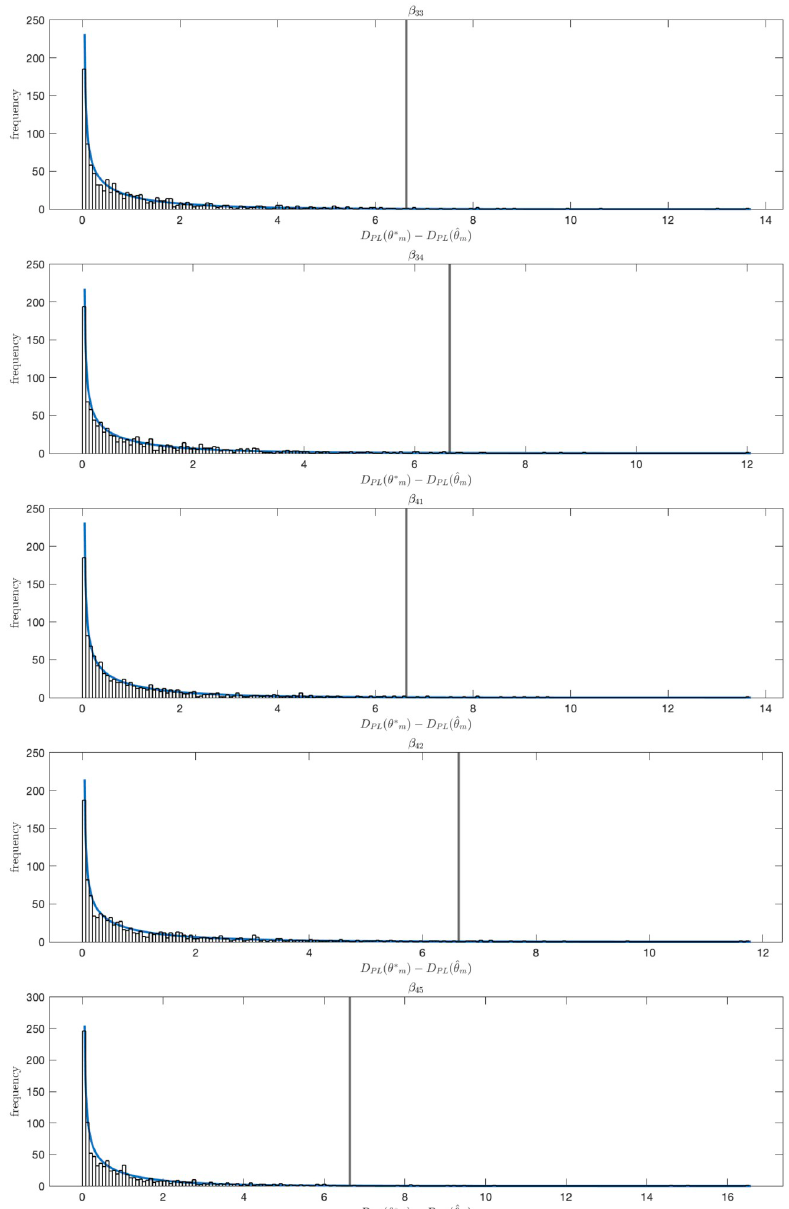
Fig 10. Validation of the coverage of the confidence intervals. The χ 2 distribution with one degree of freedom (blue) and, for a 1000 independent datasets, and for the remaining five edge parameters θ m 2 θ of the 10-edge 5 cytokine test model, a histogram of the values of D ð y � Þ (cid:0) D ð ^ y Þ , with D ð y Þ ¼ min (cid:0) 2 log ð L ð θ ÞÞ , PL PL m PL m m ~ θ m ~ θ ¼ f y ; ... ; y ; y ; ... ; y g . Here, y � ¼ 0 : 5 is the true value of θ m and ^ y its estimated value by log-likelihood 1 m m (cid:0) 1 m þ 1 N m minimization. In 99% of all cases, the value of D ð y � Þ (cid:0) D ð ^ y Þ is smaller than χ 2 (0.99, 1) (vertical grey line). PL PL m m